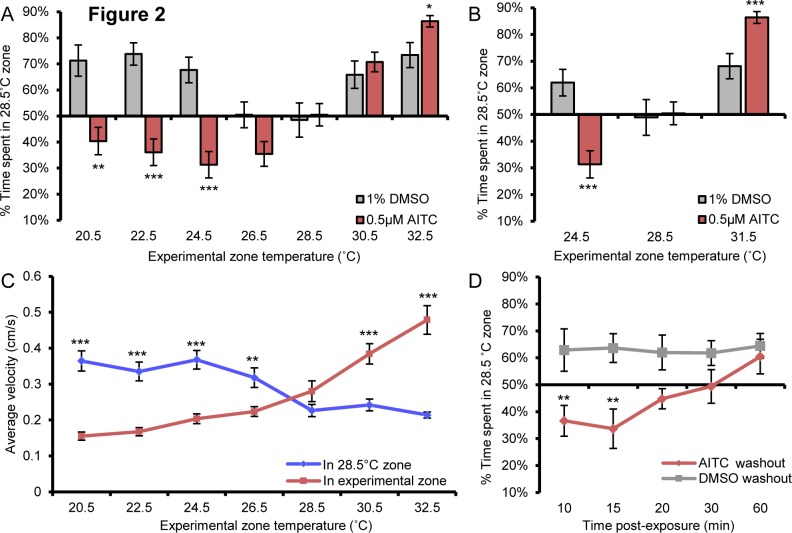
AITC promotes thermal aversion and reverses cool aversion.
A, 5dpf larvae incubated in 0.5μM AITC showed increased aversion to 32.5°C and preferred temperatures below 24.5°C when compared to responses of vehicle-treated larvae when tested against 28.5°C. AITC treated larvae also showed aversion to 28.5°C when matched to temperatures between 26.5°C and 22.5°C when compared against chance. B, AITC increases aversion to 31.5°C and reverses aversion for 24.5°C when compared to vehicle treated larvae when tested against 28.5°C (2-way anova post hoc comparison) while not affecting zone preference in the 28.5°C versus 28.5°C test. C, AITC treated larvae display increased velocity above 30.5°C when compared to velocity in the 28.5°C zone (paired student’s t-test). Conversely, AITC treated larvae showed an increased velocity in the 28.5°C zone when compared to velocity in zones cooler than 26.5°C (paired student’s t-test). D, AITC dependent aversion of 28.5°C when tested against 24.5°C is time dependent. Up to 15 min after AITC washout, treated larvae avoided 28.5°C more than vehicle treated fish but not after 20 min after washout (2-way anova post hoc comparison). * p<0.05, ** p<0.01, *** p<0.001. Error bars represent SEM.